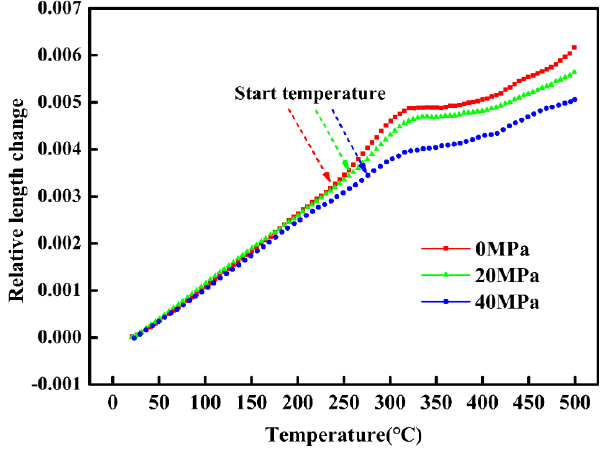
Figure 1. The thermal expansion curves during the non-isothermal process under different tensile stress.